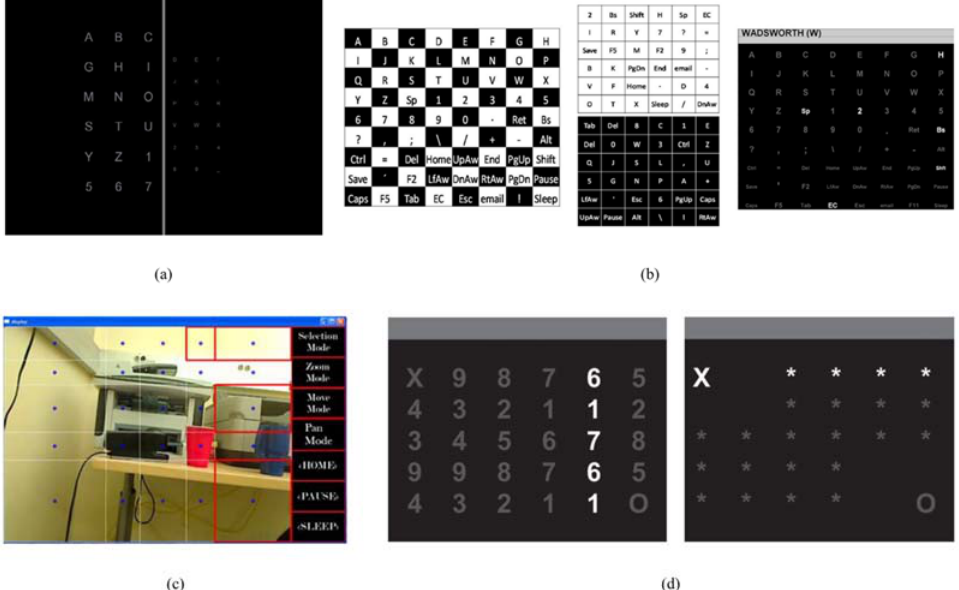
Figure 2. ( a ) An example of size differentiation of fonts in Salvaris and Sepulveda (2009) [43]; ( b ) The checkerboard approach of Townsend et al. (2010) [44]; ( c ) The non-uniform grid approach of Pathirage et al. (2013) [48]; ( d ) The two-layouts approach